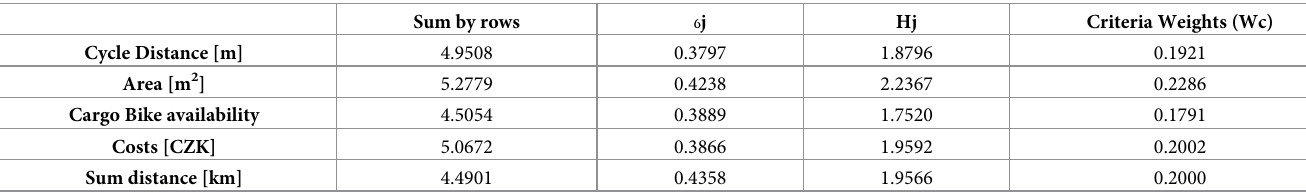
Table 15. Final criteria weights calculated by the CRITIC method.